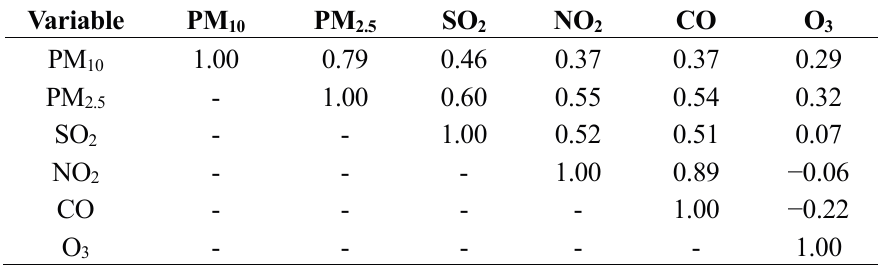
Table 2. Correlation coefficients among air